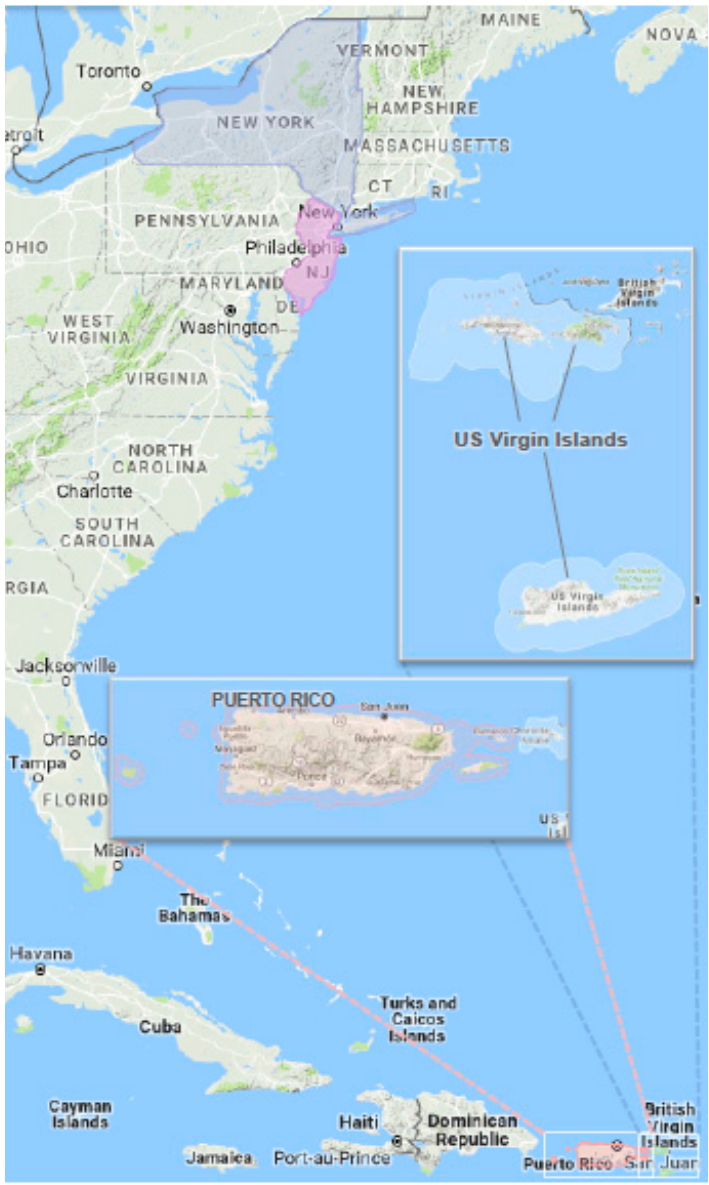
Figure 1. Map of U.S. Federal Region 2: New Jersey (NJ), New York, Puerto Rico, and U.S. Virgin Figure 1. Map of US Federal Region 2: New Jersey (NJ), New York, Puerto Rico, and US Virgin Islands Islands (image created from Google Maps). (image created from Google